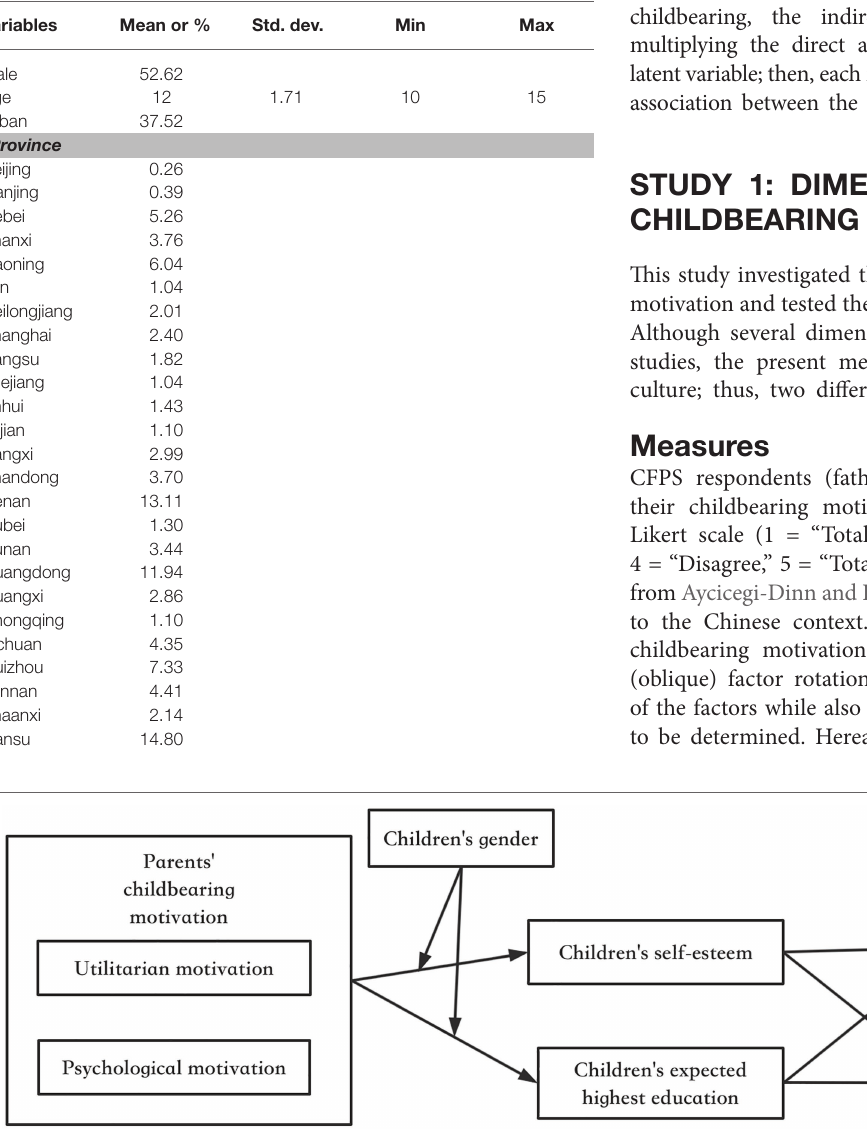
TABLE 1 | Basic demographics of the study